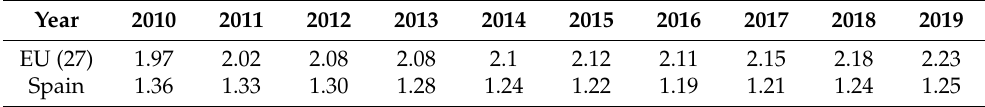
Table 1. Internal R&D expenditure (% GDP) 2010–2019